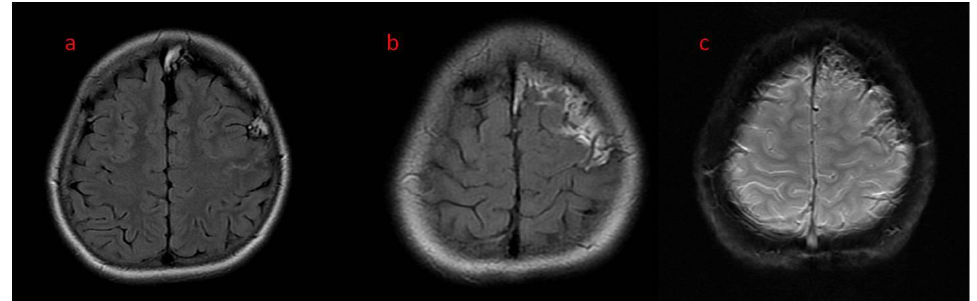
Figure 4. ( a – c ) Patient 2. Brain MR in axial plane. ( a , b ) T2 flair—left-sided frontal meningeal